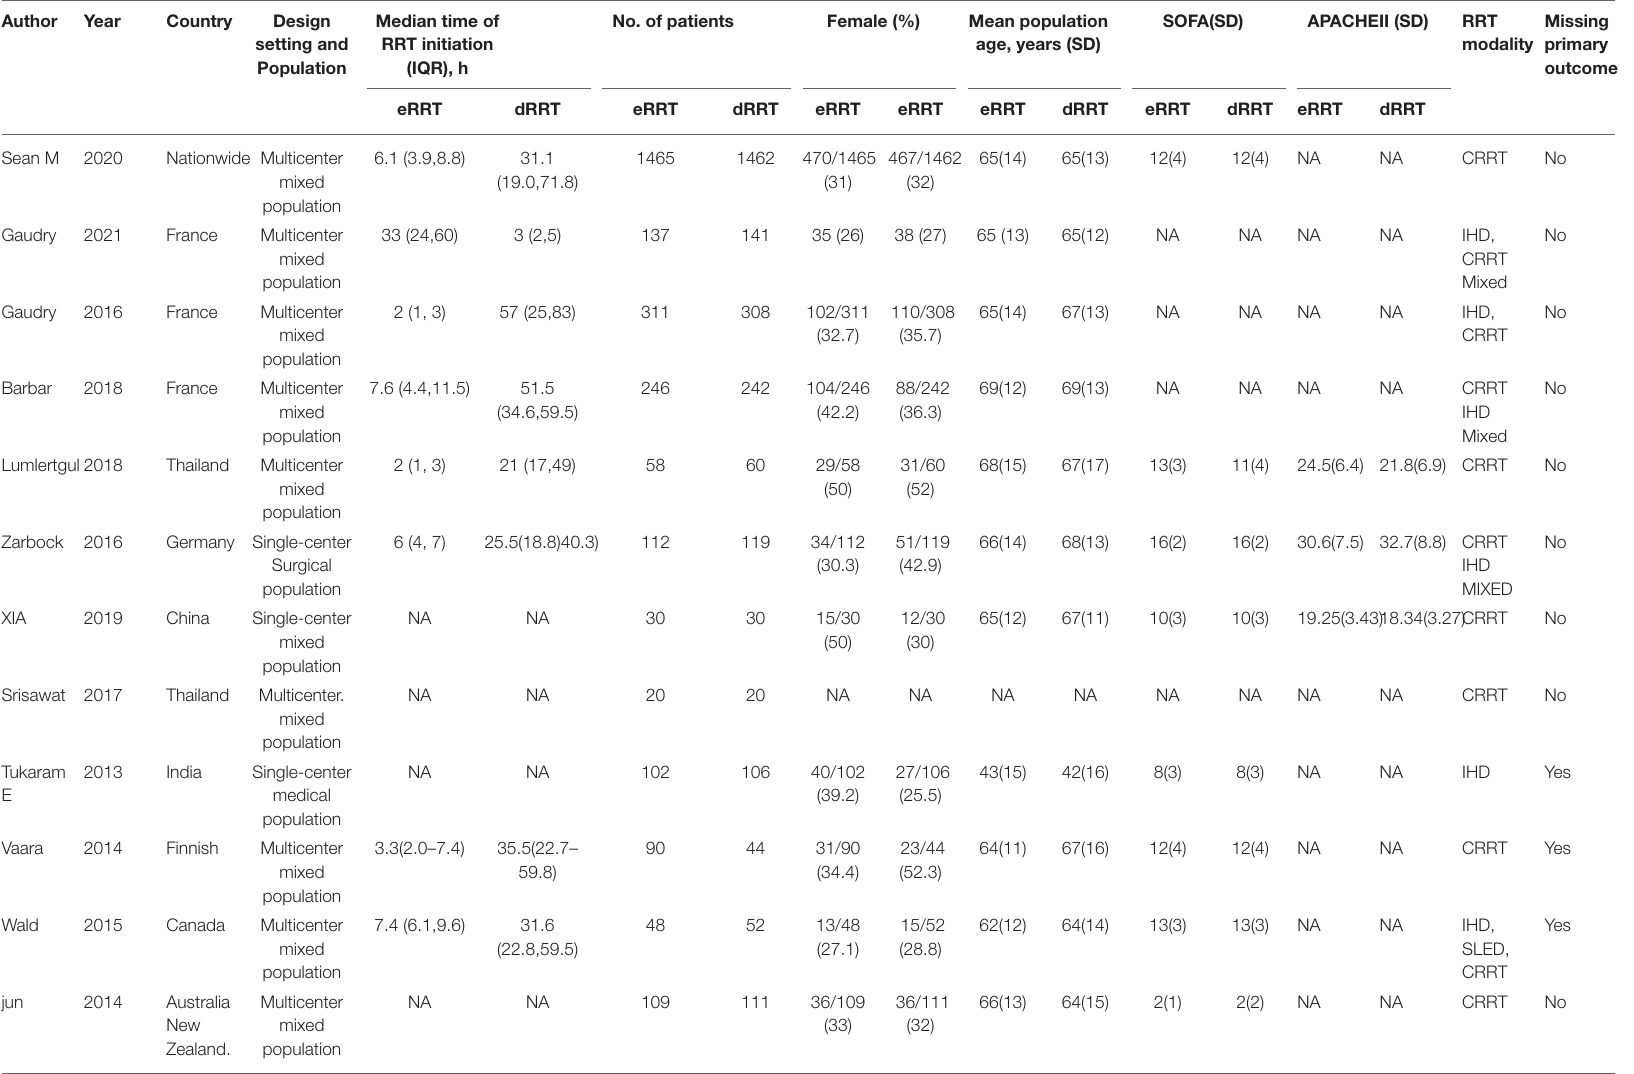
TABLE 1 | Baseline characteristics of the randomized controlled clinical trials included in the meta-analysis.